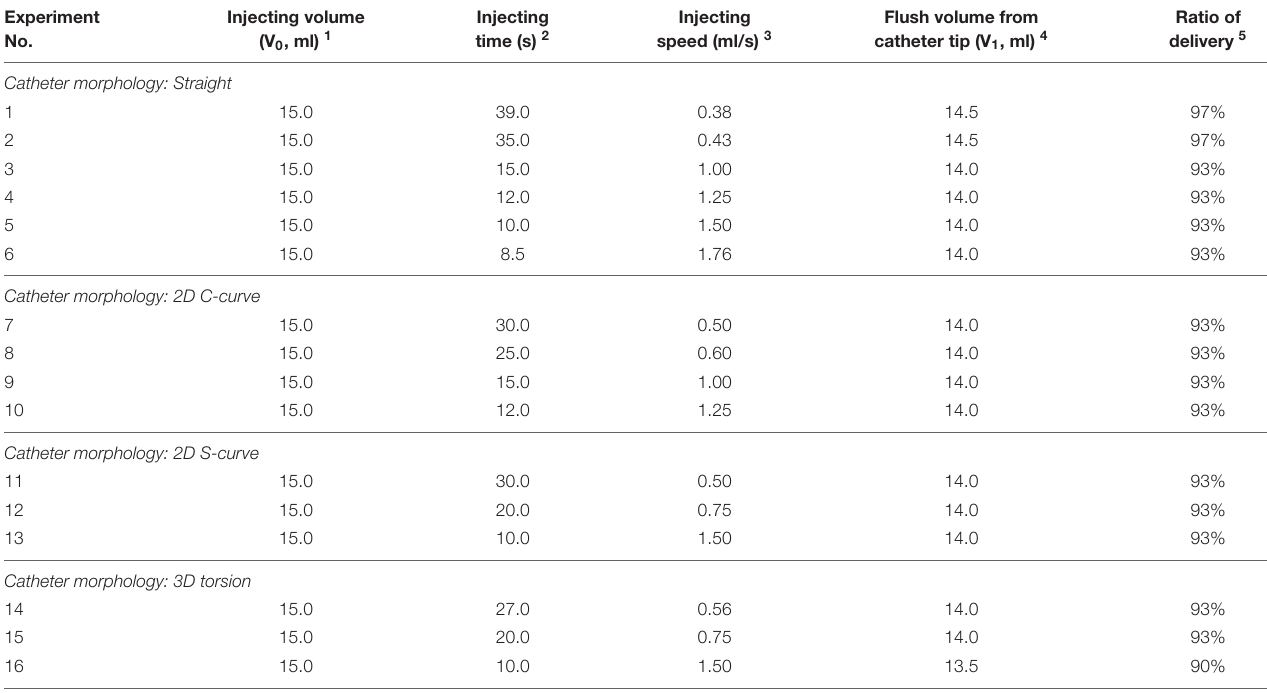
TABLE 1 | Flush delivery ratios for experiment cases with various microcatheter morphologies at different injecting speeds. Experiment